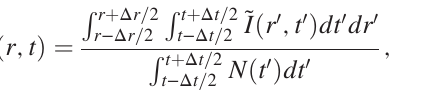
peak at I NIR ¼ 9 × 10 14 W = cm 2 . fcc peak